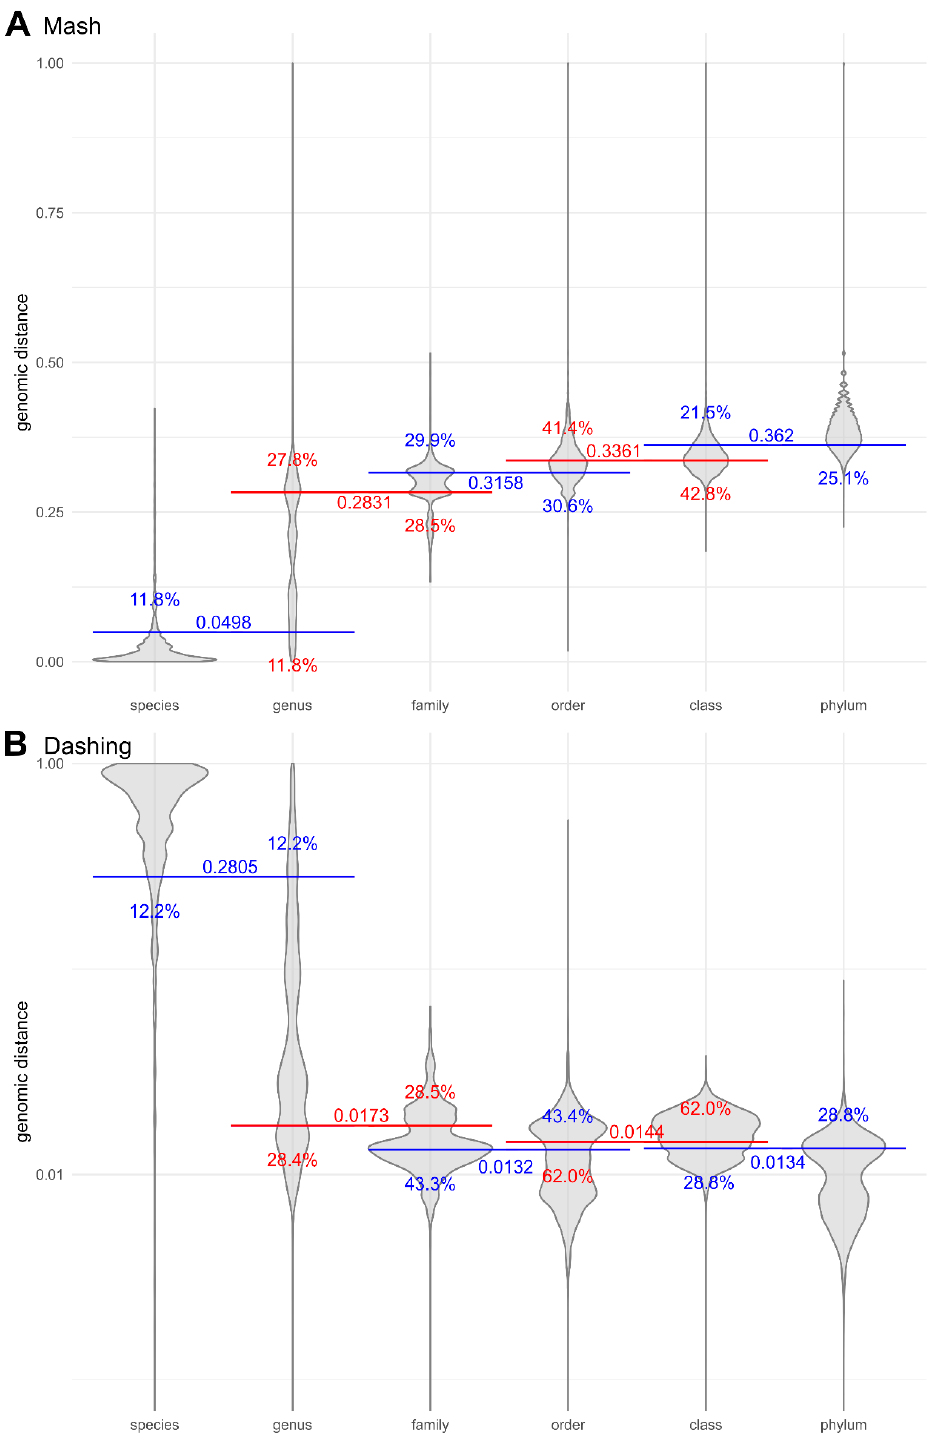
Figure 2. Genomic distances between pairs of fungal genomes at various taxonomic ranks, calculated by ( A ) Mash and ( B ) Dashing with k-mer size 16. Horizontal lines crossing pairs of taxonomic ranks show the best division lines between the ranks, calculated to minimize the share of genomic distances on the wrong side of the line (misclassified distances). Numbers next to the line mark the y -axis intercept (the genomic distance threshold), and percentages show the proportion of misclassified distances by horizontal line closest to them. The y -axis is linear for Mash distances ( A ) and logarithmic for Dashing distances ( B